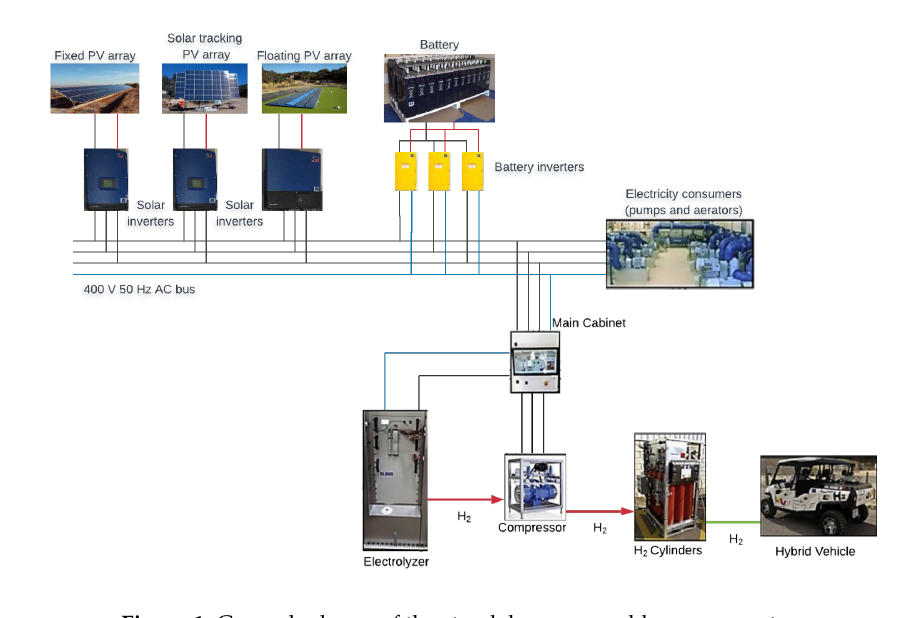
Figure 1. General scheme of the standalone renewable energy